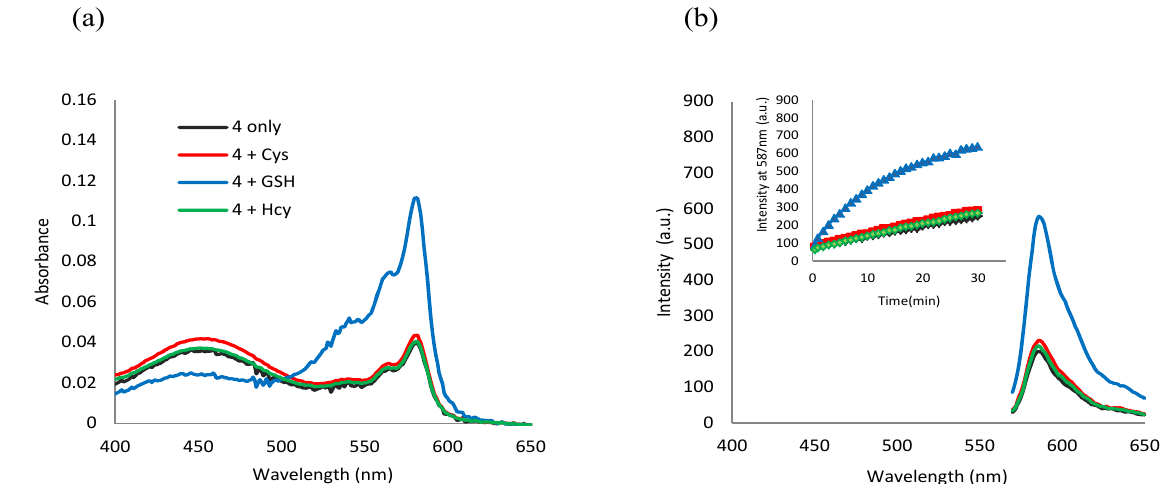
Figure 6. Surfactant mediated response of the 4- CTAB system towards various thiols at pH 6.0. ( a ) Absorption spectra of 4 (2.5 μ M) upon addition of thiols (2 equiv) in 2.0 mM CTAB media buffered at pH 6 (phosphate buffer, 50 mM) at 20 min; ( b ) Fluorescence spectra ( λ = 565 nm) of 4 (2.5 µM) upon addition of thiols (2 equiv) in 2.0 mM CTAB ex media buffered at pH 6 (phosphate buffer, 50 mM) at 20 min. The inset shows